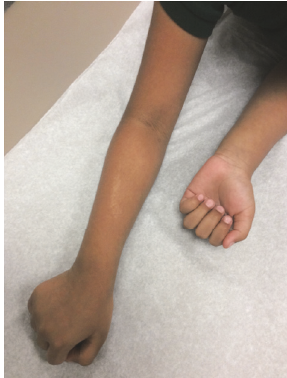
Figure 1: Hypopigmented linear eruption on the right forearm.